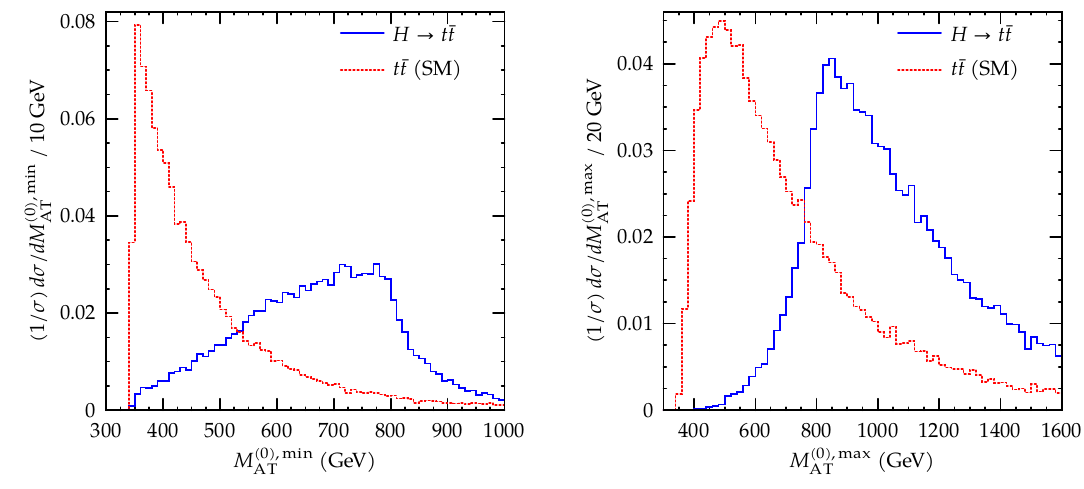
Figure 4 . The M (0) distributions for the H ! t (cid:22) t signal and the SM t (cid:22) t background at parton level. AT We have used the correct pairing of the visible